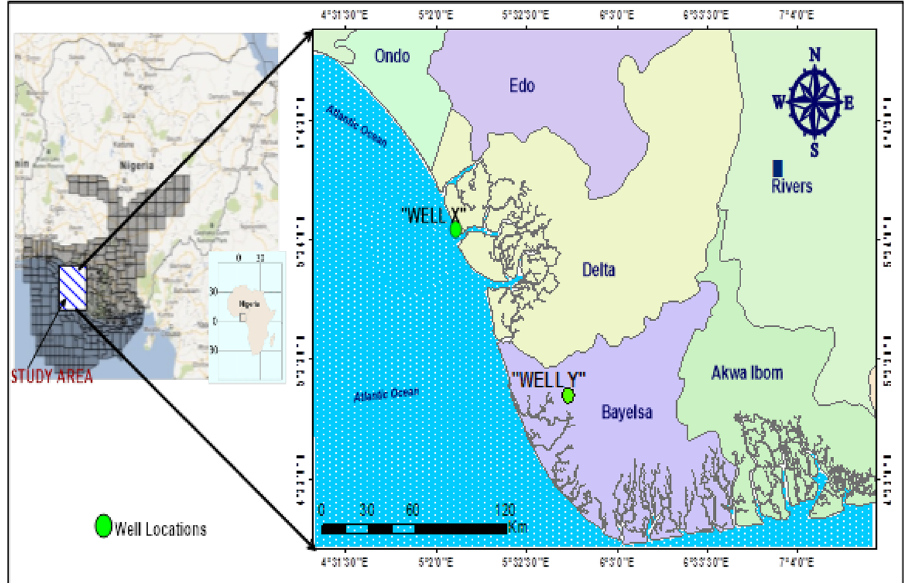
Fig. 2 Map of the Niger Delta showing location of the study